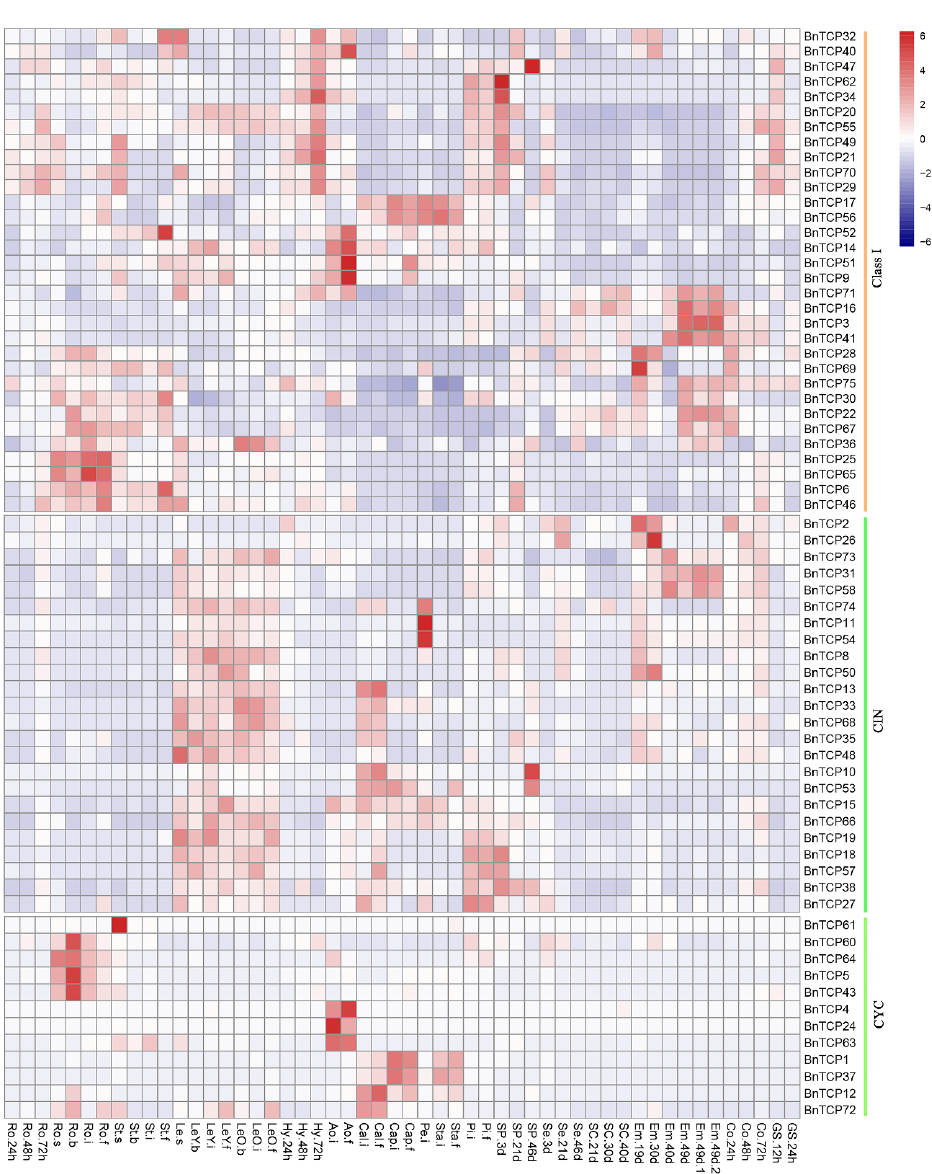
Figure 5. Expression profiles of TCP genes in Brassica napus across different developmental stages and organs. The heatmap was drawn using the R package [52]. Genes and their subgroups are shown on the right. Tissues used for expression analysis are indicated at the top of each column. Ro: root; St: stem; Le: leaf; Hy: hypocotyl; Ao: anthocaulus; Cal: calyx; Cap: capillament; Pe: petal; Sta: stamen; Pi: pistil; Sp: silique pericarp; Se: seed; Sc: seed coat; Em: embryo; Co: cotyledon; and GS: germinating seeds. D; days; H: hours. “-s”, “-b”, “-i”, and “-f” represent the “seedling”, “bud”, “initial flowering”, and “full bloom” stages of B. napus, respectively. Colored bars represent log2 expression values. Red, green, and black indicate high, low, and medium gene expression levels,